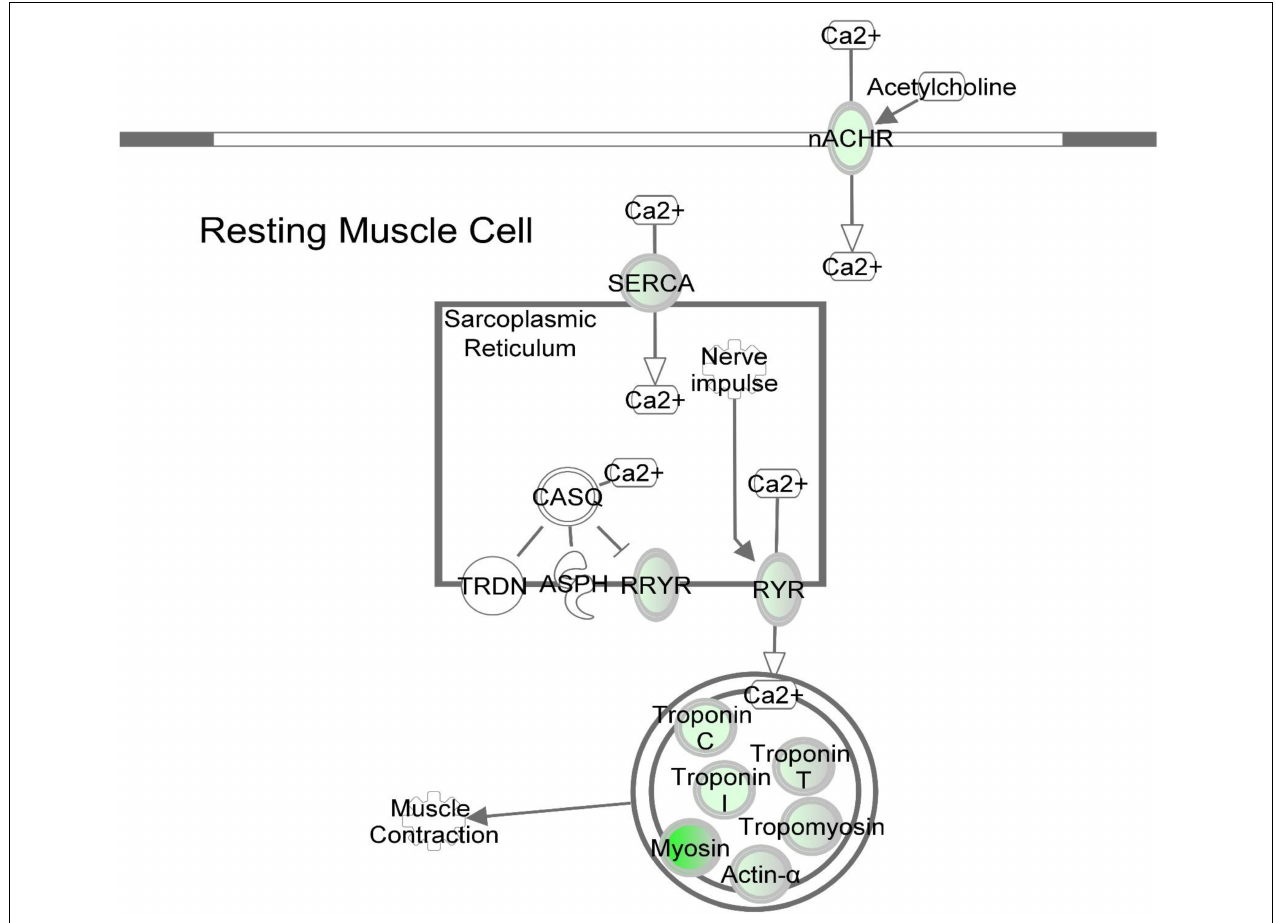
FIGURE 6 | DAP knockdown alters expression of calcium signaling genes during differentiation of turkey satellite cells. Intermolecular connections between genes are as defined by IPA analysis. *FDR < 0.05, **FDR < 0.01, and ***FDR < 0.001. ASPH, aspartate beta-hydroxylase; CASQ, calsequestrin; DHPR, dihydropyridine receptor; nACHR, nicotinic cholinergic receptor gamma subunit; RYR, ryanodine receptor; RRYR, RYR interaction network; SERCA, sarcoplasmic/endoplasmic reticulum Ca 2 + -ATPase; TRDN, Triadin. Symbols are defined as in Figure 4 . Red highlighting indicates up-regulated genes; green highlighting indicates down-regulated genes. This pathway was generated through the use of Ingenuitay Pathway Analysis (QIAGEN, Inc. https://digitalinsights.qiagen.com/products-